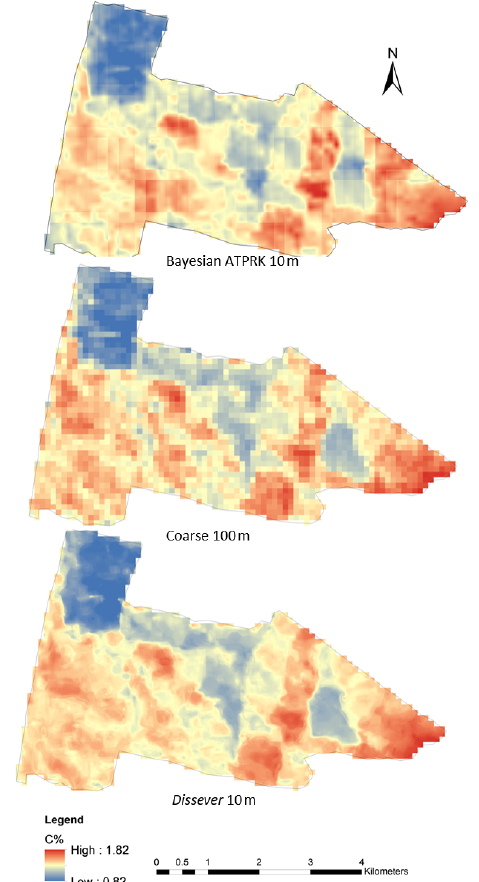
Figure 8. Comparing the disaggregated map with original coarse- scale SOC